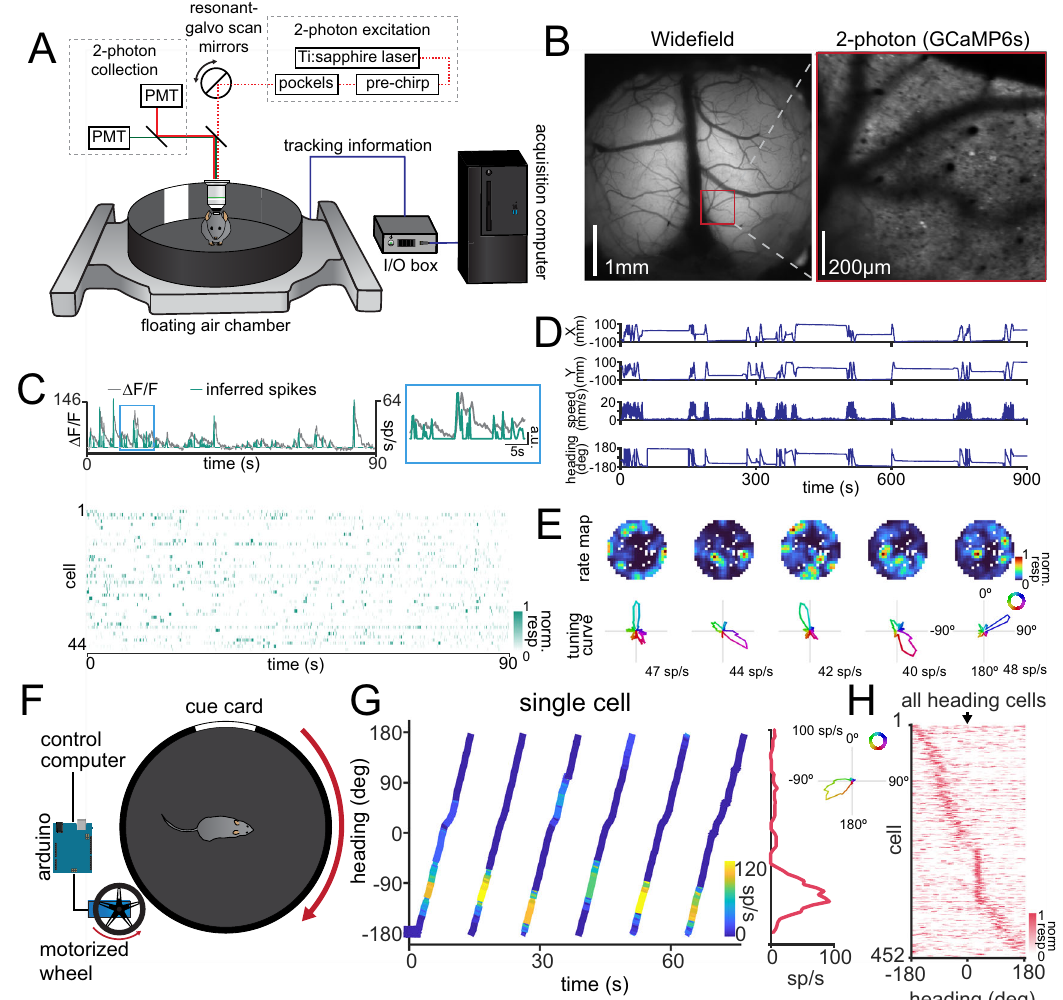
Fig. 1 | Individualneurons in theRSC exhibitheadingresponsesinthe absence of physical head movement. A Schematic of the imaging set-up. Mice are head fi xedina fl oatingchamberandallowedtovoluntarilymovethechamber fl oorusing their paws, allowing control of their position and orientation within the chamber. Tracking information from the chamber is synchronized to the collection of the two-photon image acquisition. B Left: Example wide fi eld image of the entire cor- tical window with the location of the imaged plane in dysgranular RSC indicated with a red box. Scale bar = 1mm. Right: Example imaging plane in RSC using two- photon microscopy ( n =4 imaging fi elds over 3 mice) Scale bar = 200 µ m. C Top: Neural responses are fi rst extracted as changes in fl uorescence ( Δ F / F ), then spikes areinferredfromthecalciumtraces.Graytracesshowthe Δ F / F traceandthegreen trace shows the inferred spikes. Inset: Zoomed section of the blue box on the left. Bottom: Example inferred spikes from a population of cells in a single recording. D Example chamber tracking data from a single experiment, showingX position, Y position, speed, and heading angle. E Example rate maps (top) and heading